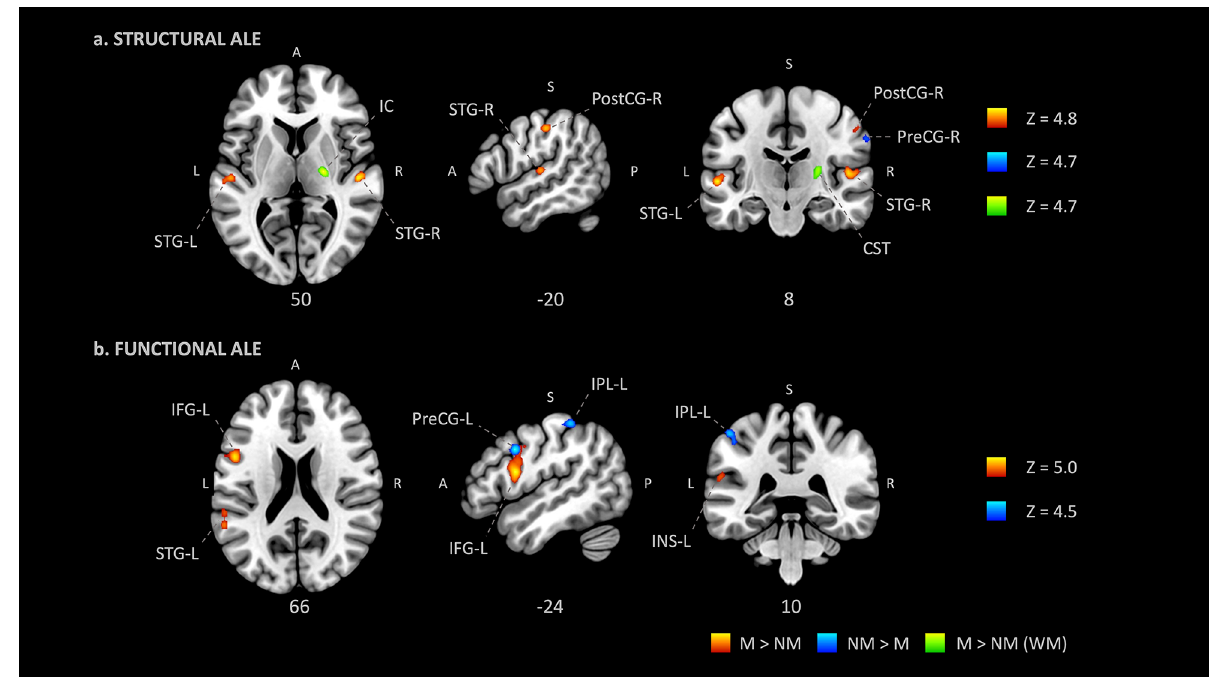
Figure 1. Anatomic likelihood estimation meta-analytic results for studies comparing brain structure and function between M and NM at cluster level inference p < 0.05 (FWE). The primary outcome included ALE meta-analysis of the contrast M vs NM for structural and functional modalities, independently. M > NM = higher volume/activity in musicians; NM > M = lower volume/activity in musicians; GM grey matter, WM white matter, L left, R right, A anterior, P posterior, Z peak Z-value, IC internal capsule, INS insula, IPL inferior parietal lobule, PostCG postcentral gyrus (primary somatosensory cortex, or S1), PreCG precentral gyrus (primary motor cortex, or M1), STG superior temporal gyrus (primary auditory